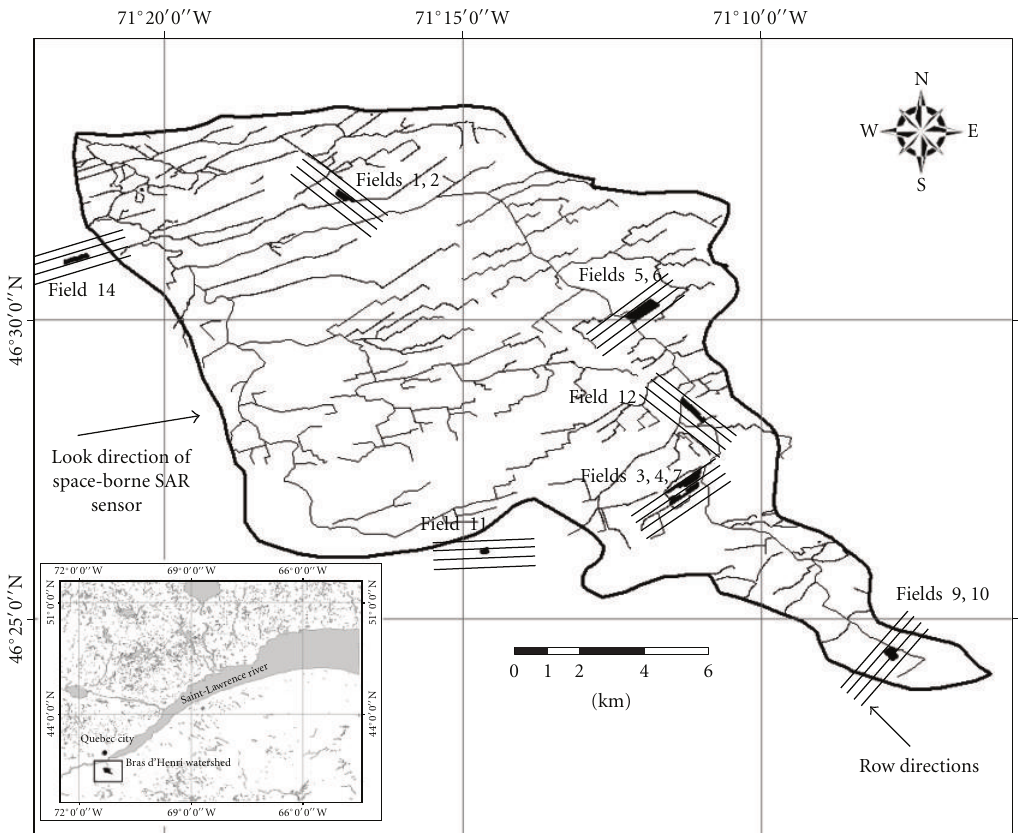
Figure 1: Location of the 12 study fields within the Bras d’Henri